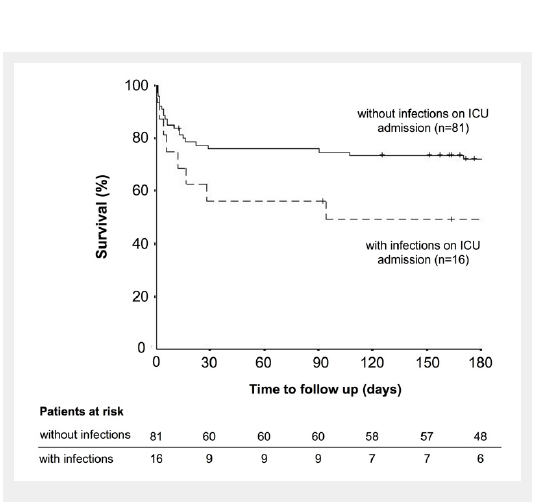
The curves show survival rates over time for acute heart failure patients with (dashed line, n = 16) and without (straight line, n = 81) infections on ICU admission (Log rank p = 0.08). The small vertical lines indicate the time points when a patient had his latest follow up. In addition, the numbers of patients at risk are tabulated for the main intervals of the rate of survival